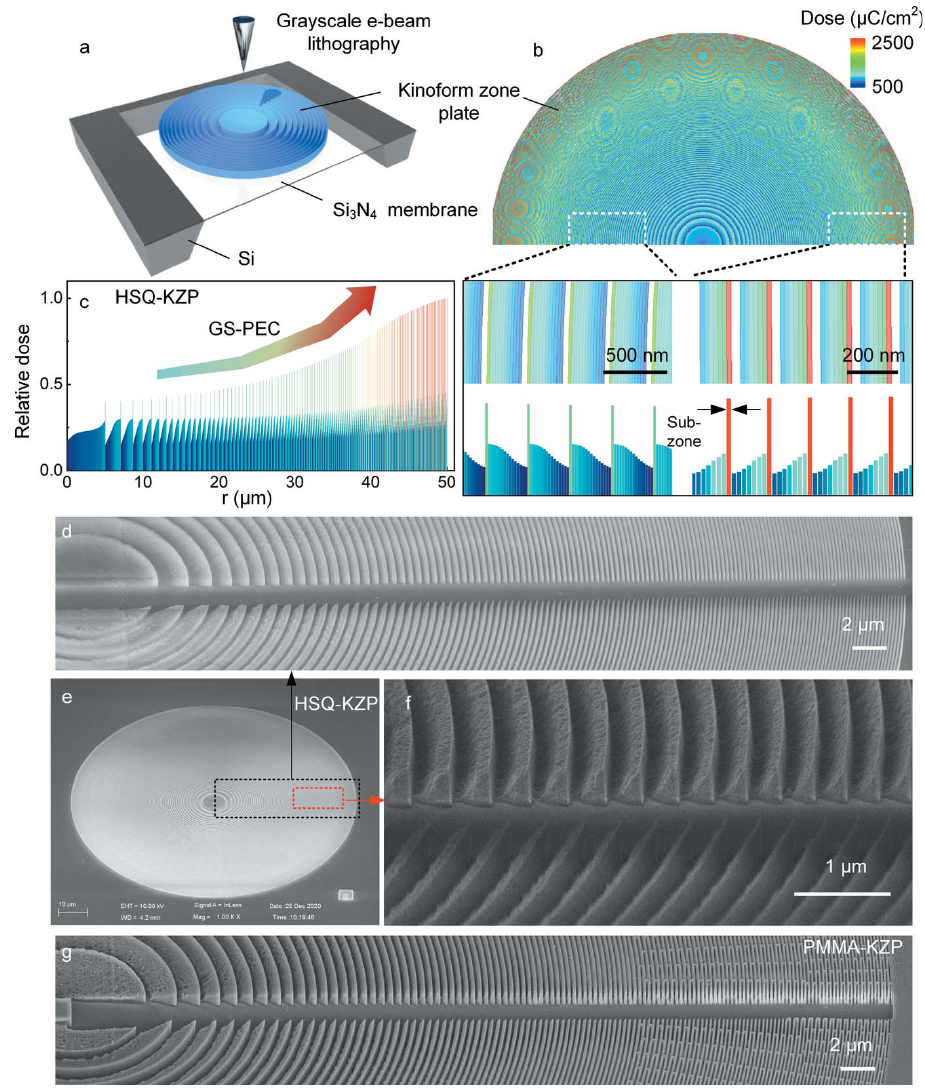
Figure 3 Overview of the fabrication procedures. ( a ) Schematic illustration of greyscale electron beam lithography (GS-EBL) for the HSQ-KZP lens as an example. ( b ) The calculated dose gradient pattern for the HSQ-KZP lens by GS-EBL. ( c ) Dose distribution curves for the HSQ-KZP in which the greyscale proximity effect correction (GS-PEC) was applied. ( d ) Micrographs by SEM of the cross-sectional view at a tilt of 45 (cid:6) for the fabricated KZP lenses in HSQ. ( e ) The whole fabricated HSQ-KZP lens. ( f ) Close-up view at a tilt of 75 (cid:6) of the replicated HSQ-KZP zones. ( g ) Cross-sectional view at a tilt of 45 (cid:6) of the PMMA-KZP